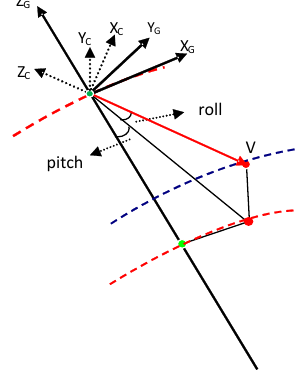
Figure 3. The calculation of the attitude parameter of the sensor The centre image-point of the starting line, the corresponding ground point and project centre meet the collinear equation (7) ( Zhang and Pan, 2003).